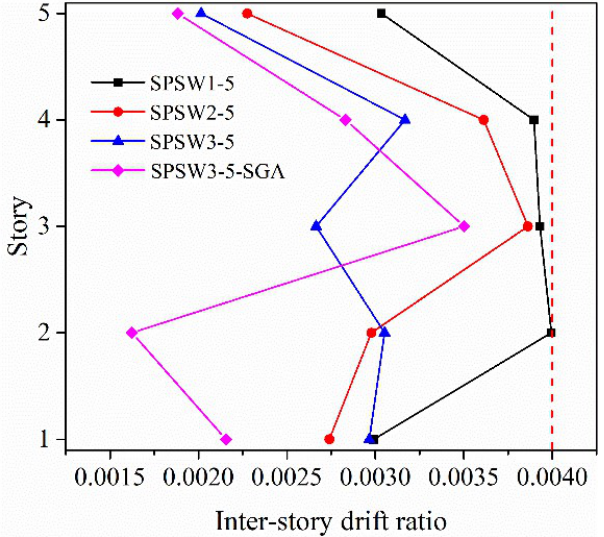
Figure 10. Inter-story drift ratio for optimum designs of 5-story steel frame. Table 7. Maximum and average stress ratios of the frame and plate elements for structures with a 5-story steel